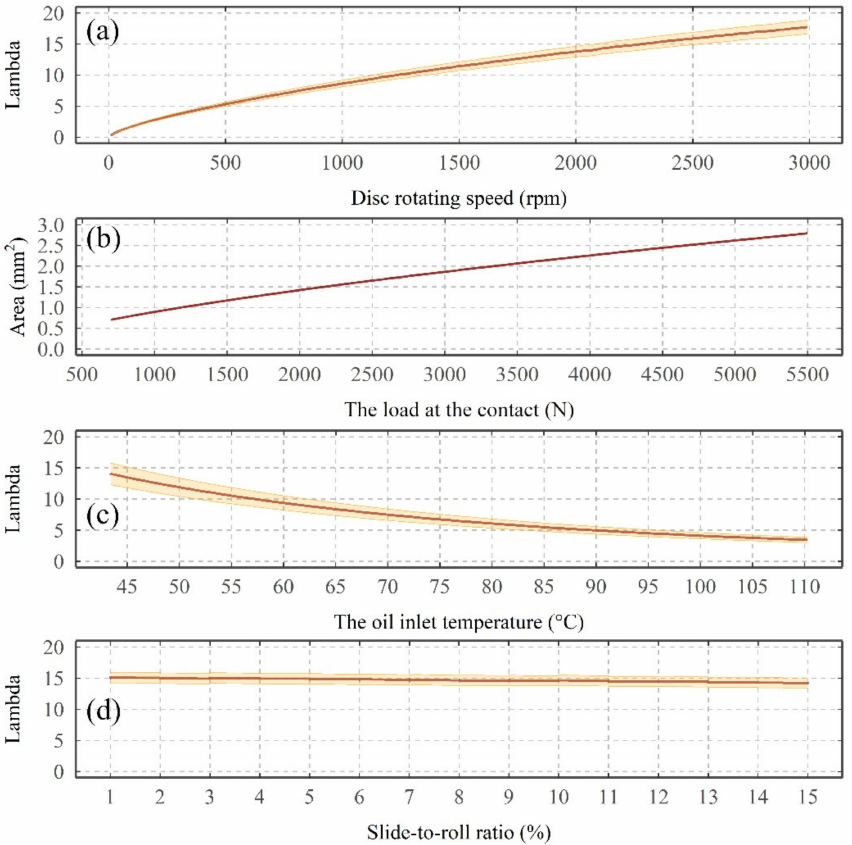
Figure 14. Influence of ( a ) disc rotating speed, ( c ) the oil inlet temperature and ( d ) slide-to-roll ratio on the experienced lambda. The ribbon area marks the calculated lambda based on the initial and the final roughness measurements. ( b ) Changes in the experienced contact area as a function of the load at the